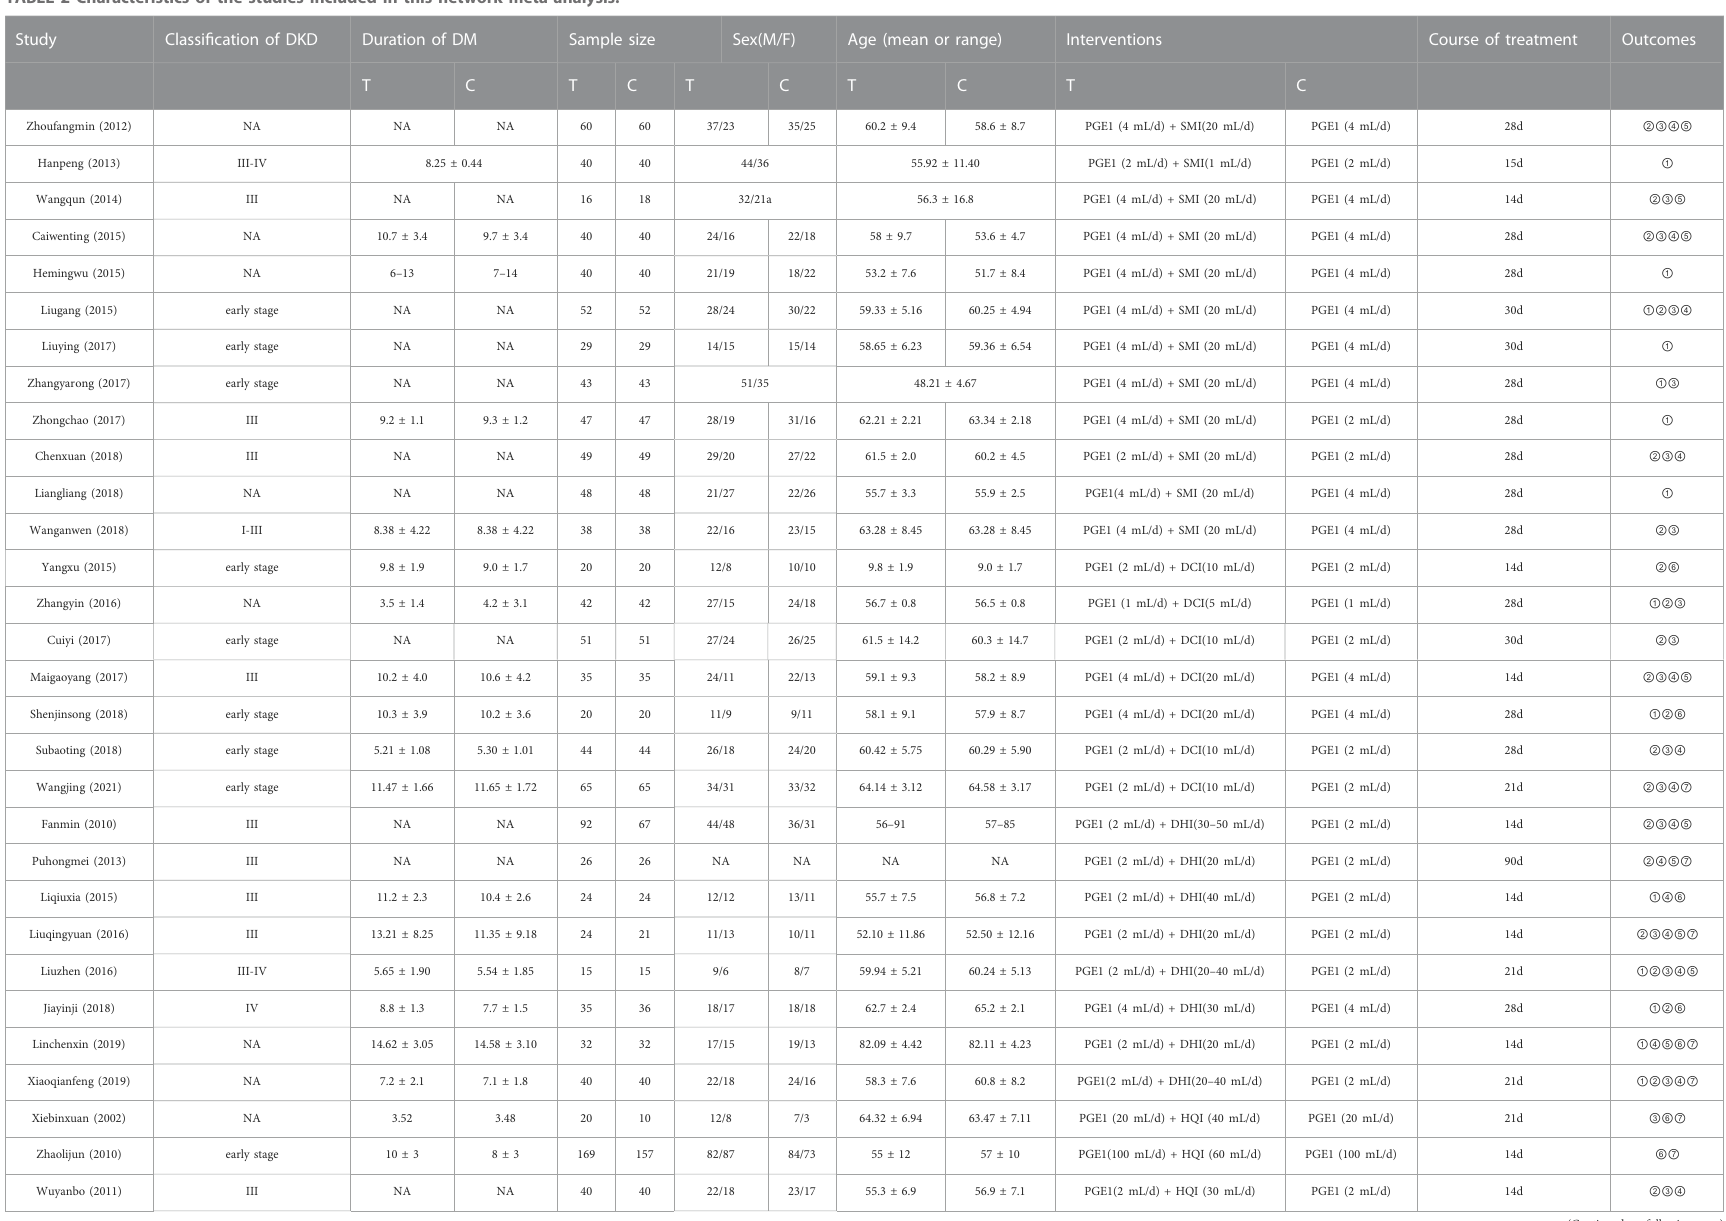
TABLE 2 Characteristics of the studies included in this network